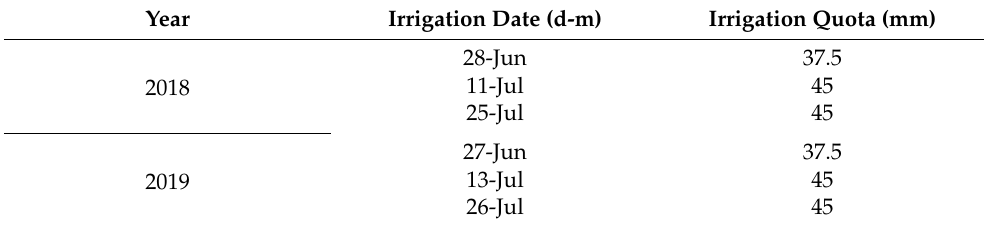
Table 2. Irrigation